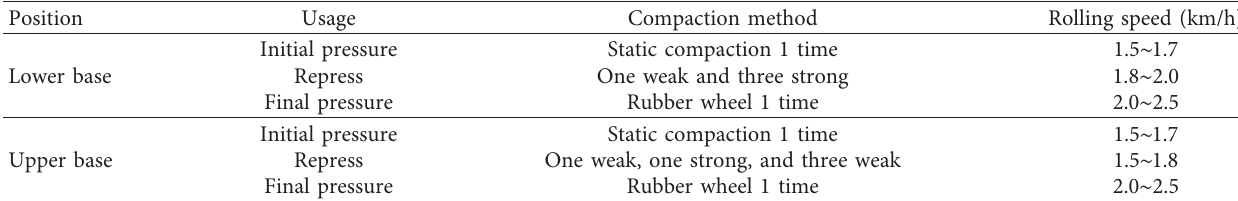
Table 10: Compaction process of double-layer continuous paving